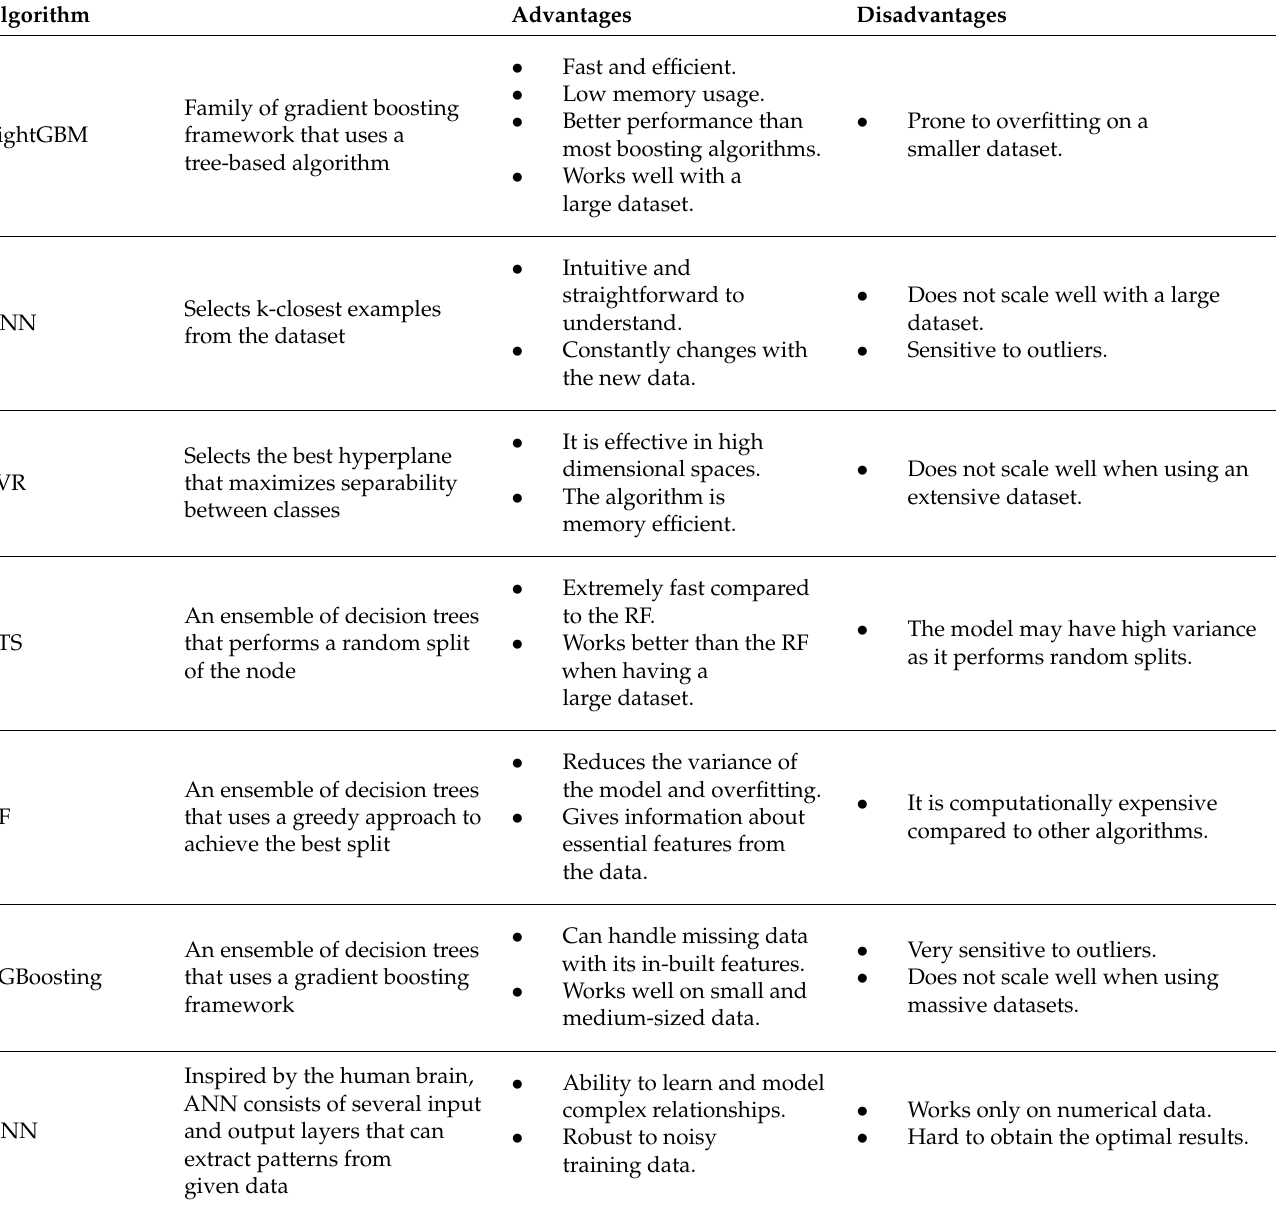
Table 2. A conceptual comparison of single prediction models for smart waste